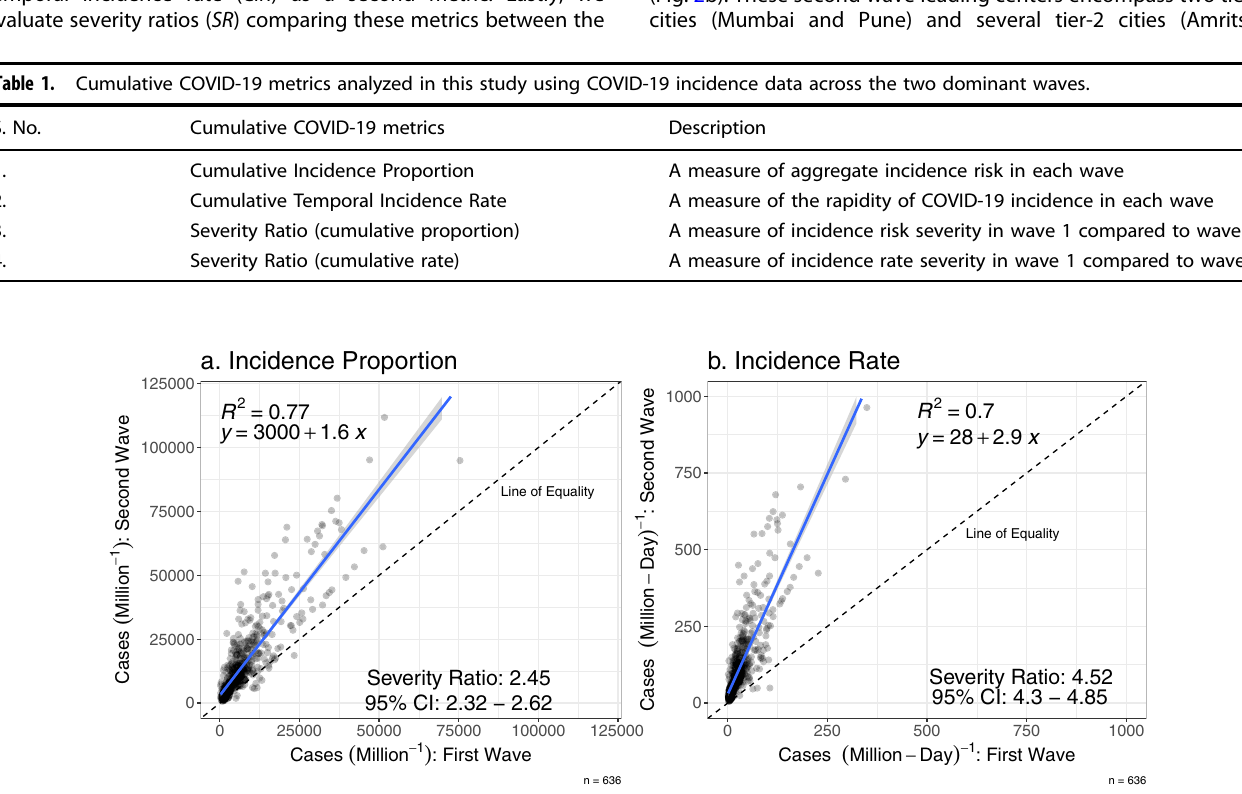
Fig. 1 Higher COVID-19 incidences in the second wave compared to the fi rst wave, on average. Comparing COVID-19 ( a ) cumulative incidence proportion (per one million people) and ( b ) cumulative incidence rate (per one million person-day), between the fi rst ( x axis) and the second ( y axis) wave. The dashed line indicates the line of equality, and the solid blue line represents linear regression fi t. COVID-19 incidence proportions and rates were on average higher in the second wave than in the fi rst wave. The panels also show the estimated average severity ratio and 95% con fi dence interval based on bootstrap estimations with 100,000 replications. Spearman ’ s correlation coef fi cients between the fi rst and second wave are 0.87 and 0.86, for cumulative incidence proportions and rates, respectively, and signi fi cant at the 0.01